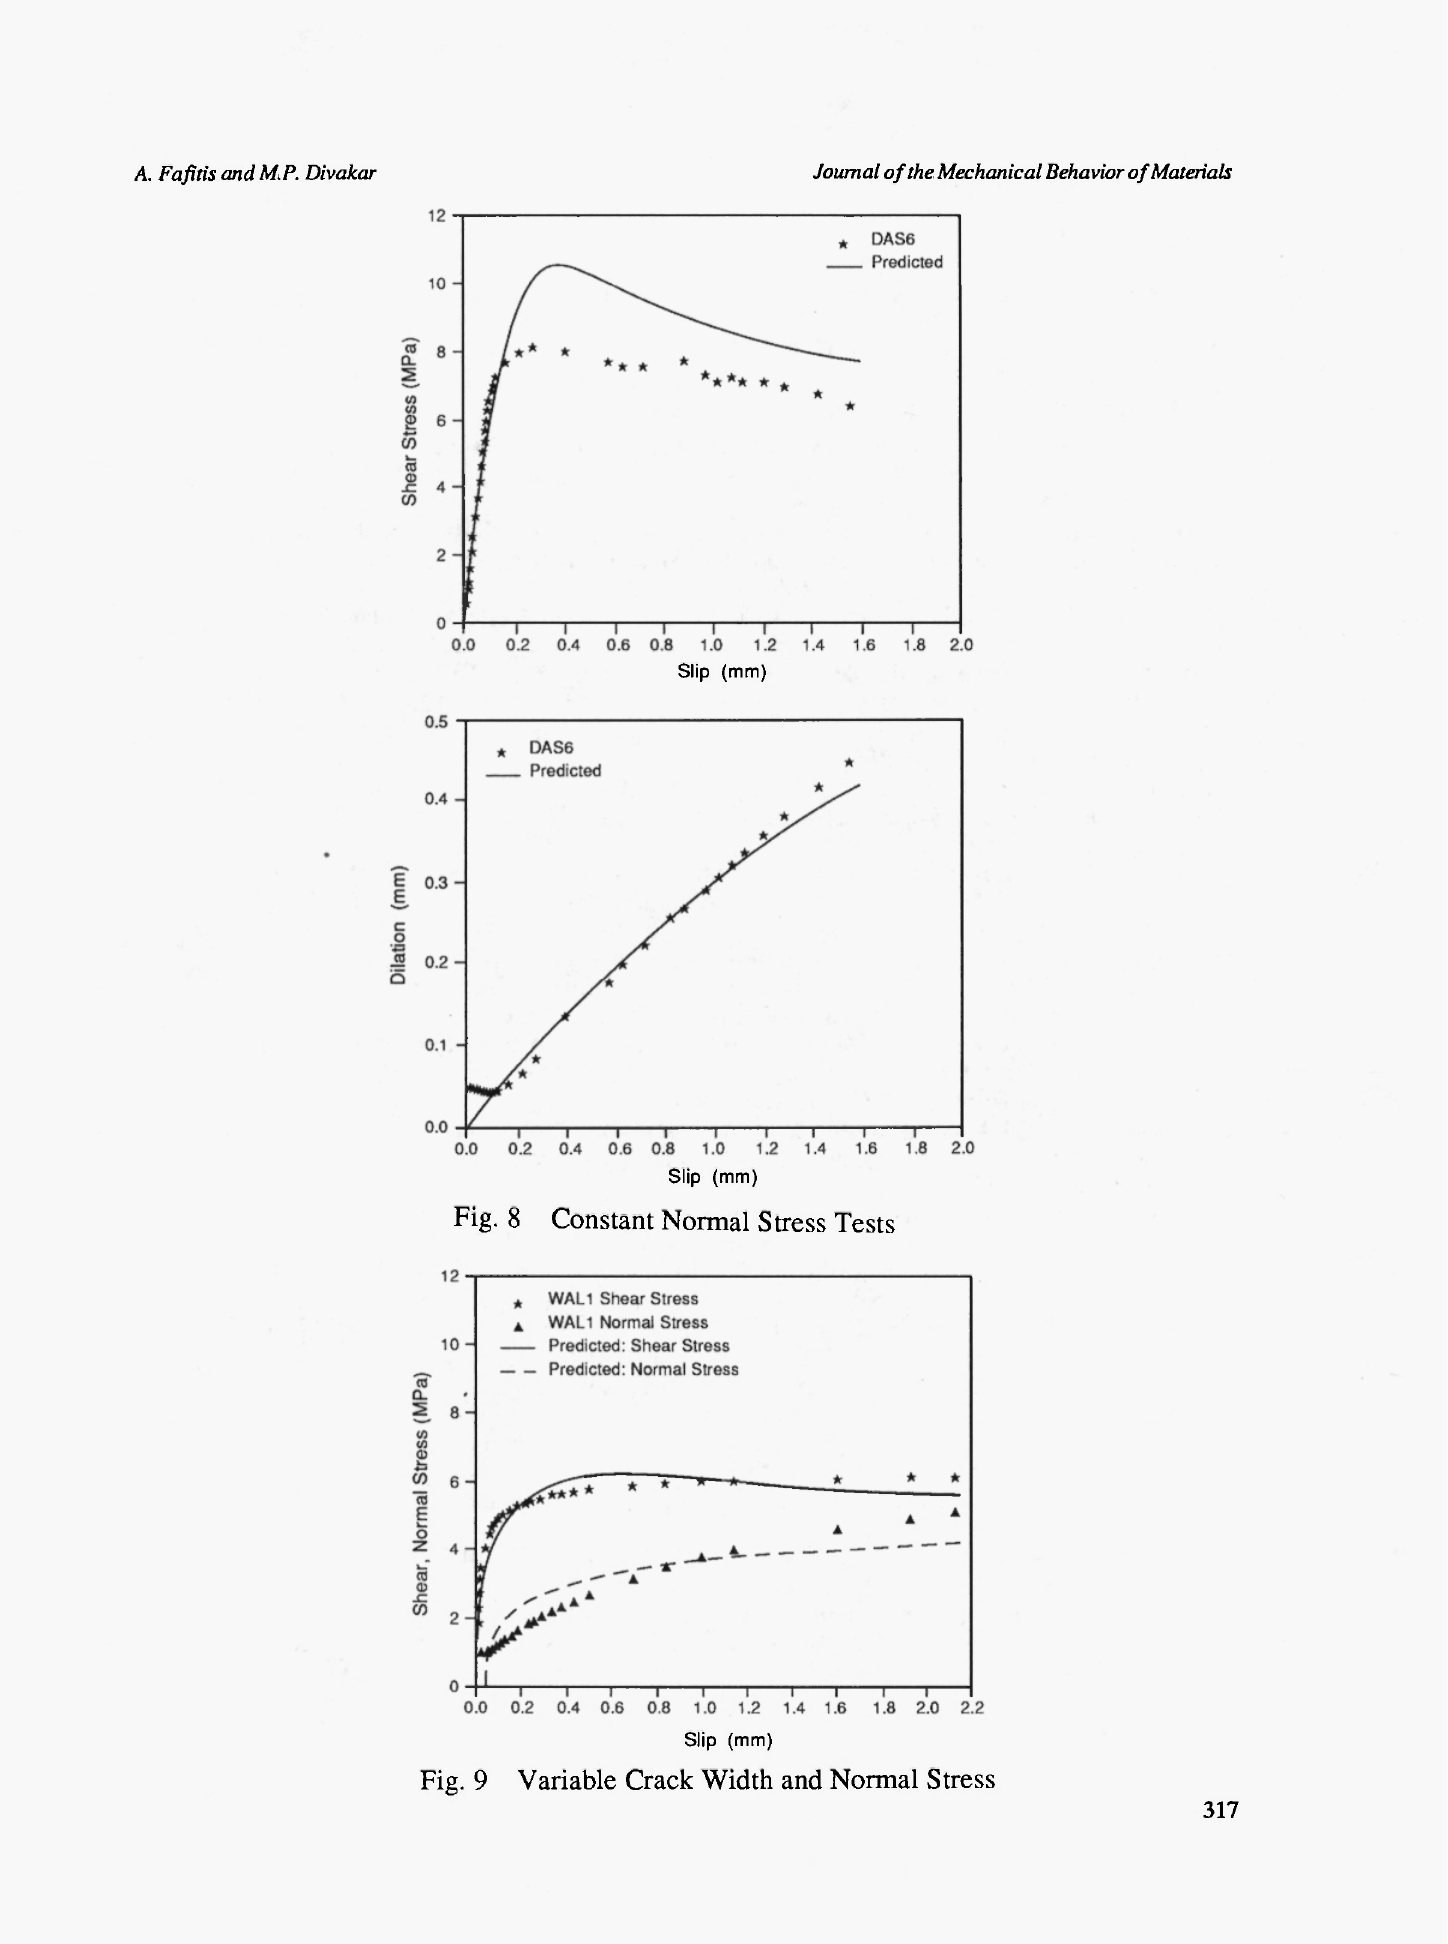
Fig. 8 Constant Normal Stress Tests